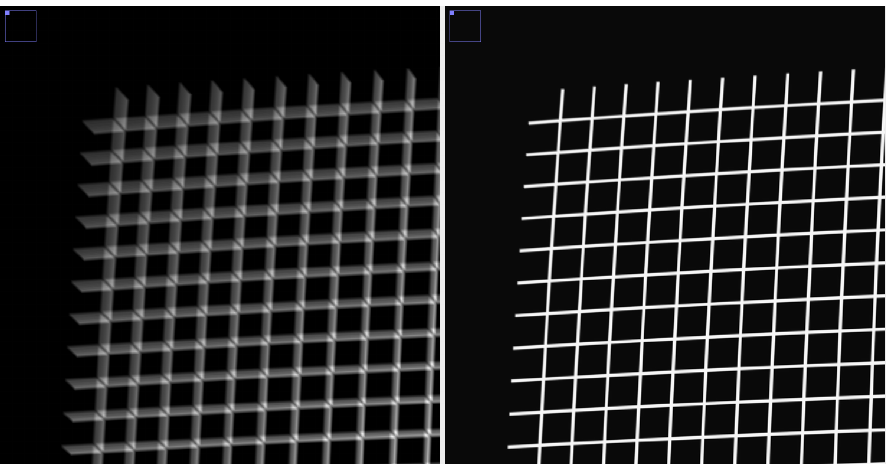
Figure 3. Phantom movie (grid, detail), an average of 50 frames, frames shifted + doming applied, using only global alignment ( left ), after local alignment ( right